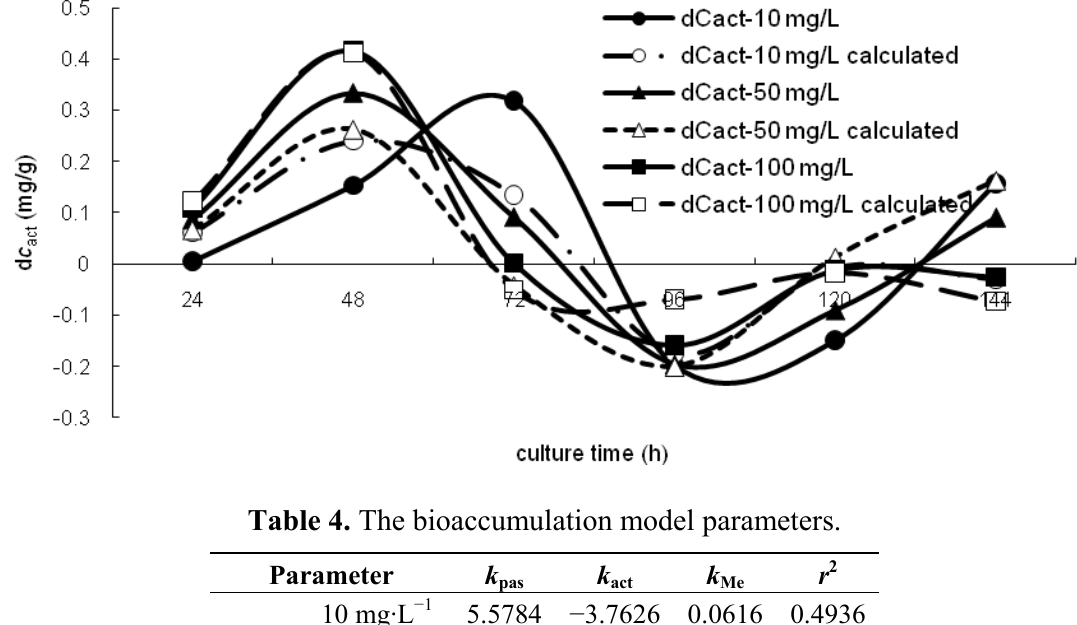
and d c with calculated data for the bioaccumulation model. act act